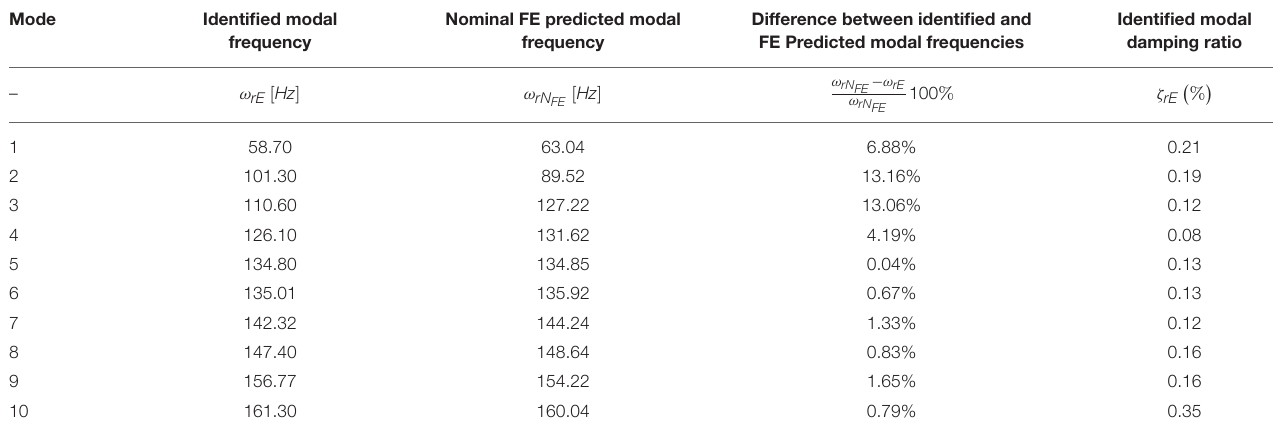
TABLE 1 | Identified and nominal FEM predicted modal frequencies and modal damping ratios of the intermediate pressure turbine. Mode Identified modal Nominal FE predicted modal Difference between identified and frequency frequency FE Predicted modal frequencies